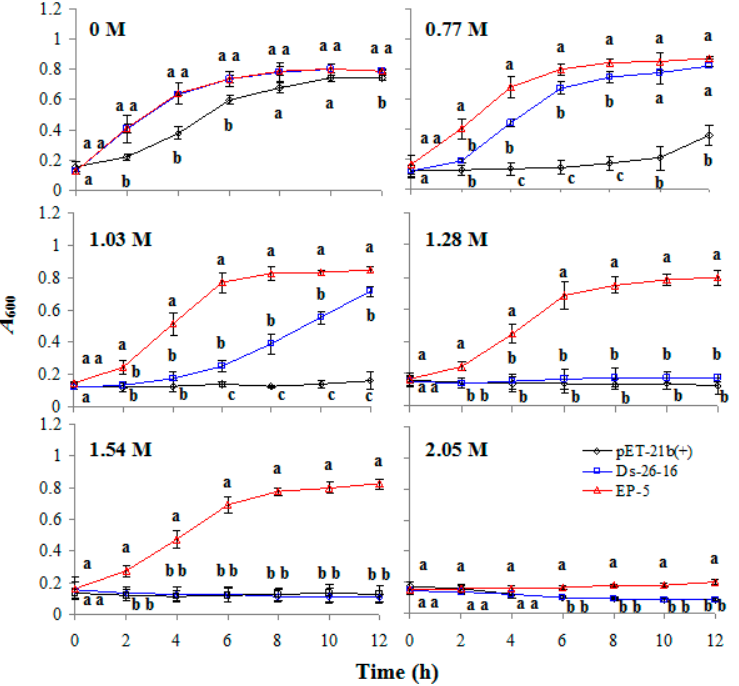
Figure 1. The salt tolerance of EP-5 transformant. The growth status ( A 600 ) of pET-21b(+), Ds-26-16 and EP-5 under different NaCl concentrations. a, b or c stands for the significant differences between the strains under the same concentration at the same growth time ( p < 0.05).